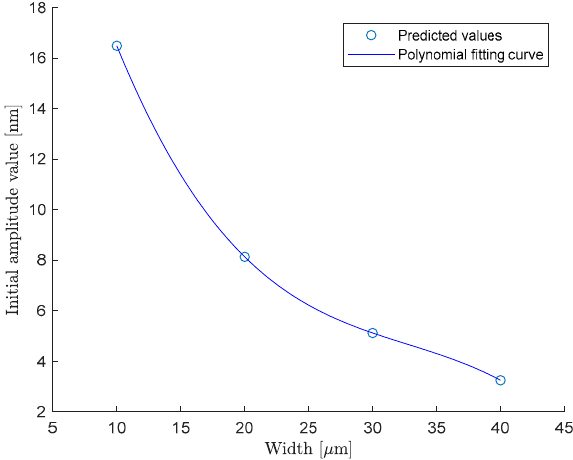
Figure 4. The influence of beam width on the decrease in the initial value of the amplitude.